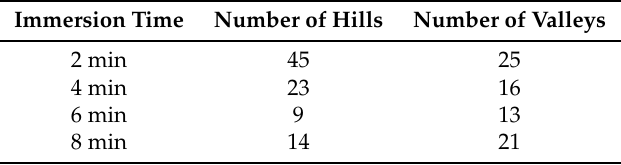
Table 2. The number of hills of height greater than 1 µ m (i.e., spherulites and spherulite-like structures) and valleys (i.e., pores, cavities, etc.) versus immersion time of PC. The decrease in the number of hills indicates the aggregation when the immersion time increases.